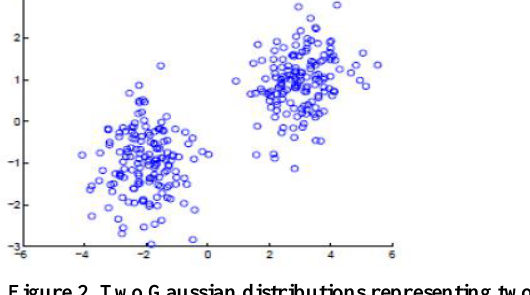
Figure 2. Two Gaussian distributions representing two clusters. Table 1. Characteristics of UCI data